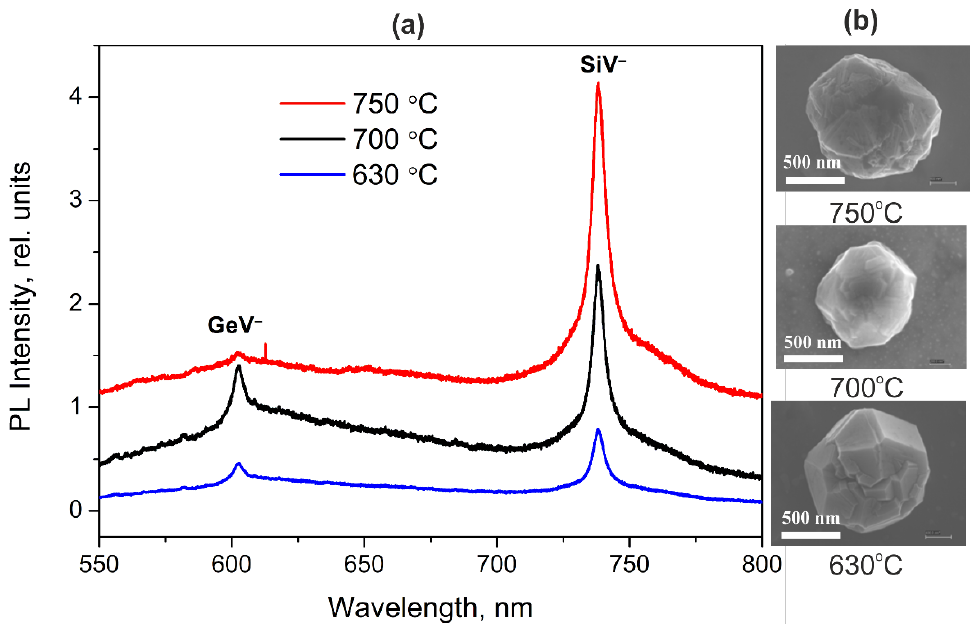
Figure 3. ( a ) Luminescence spectra of HFCVD NDs with embedded GeV − and SiV − centers synthe- sized on silicon substrate at different substrate temperatures of 630 °С, 700 °С, and 750 °С; ( b ) typical SEM images of ND particles grown at different substrate temperatures.